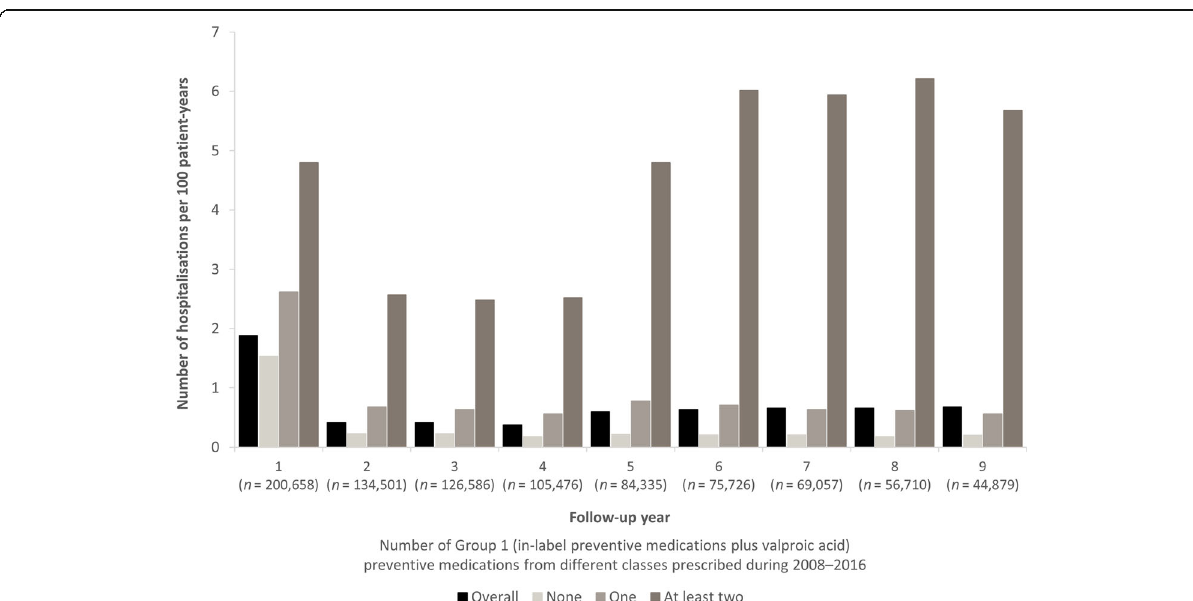
Fig. 8 Frequency of hospitalisations of patients with migraine in the German Company Sickness Fund Database by number of in-label preventive medications from different classes. Data are shown for all patients (overall) and patients grouped according to the number of restricted Group 1 (propranolol, metoprolol, flunarizine, topiramate and amitriptyline, but not onabotulinum toxin A or valproic acid) preventive medications from different classes prescribed during 2008 – 2016. n overall number of patients each year; patients were not required to be enrolled over the total study period (2008 – 2016), but were required to be continuously observable. For example, a person could enter the sample later than 2008